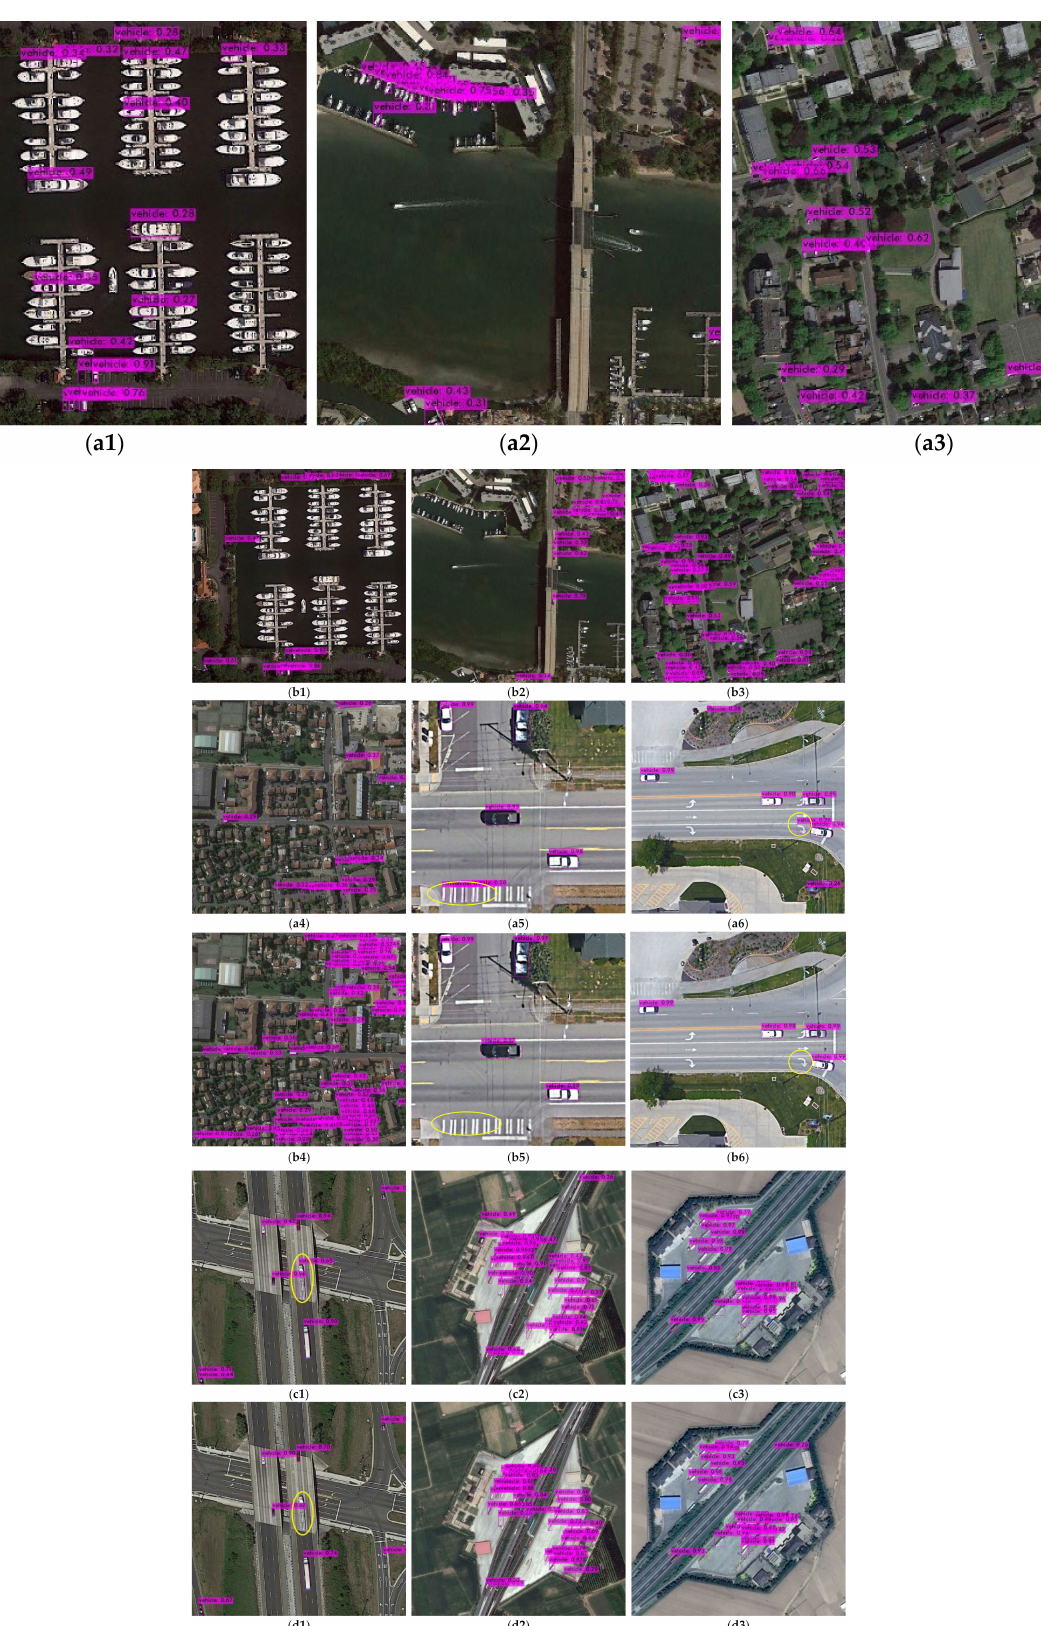
Figure 7. Comparison of detection results between YOLOv4 ( a1 – a6,c1 – c3 ) and RepDarkNet ( b1 – b6,d1 – d3